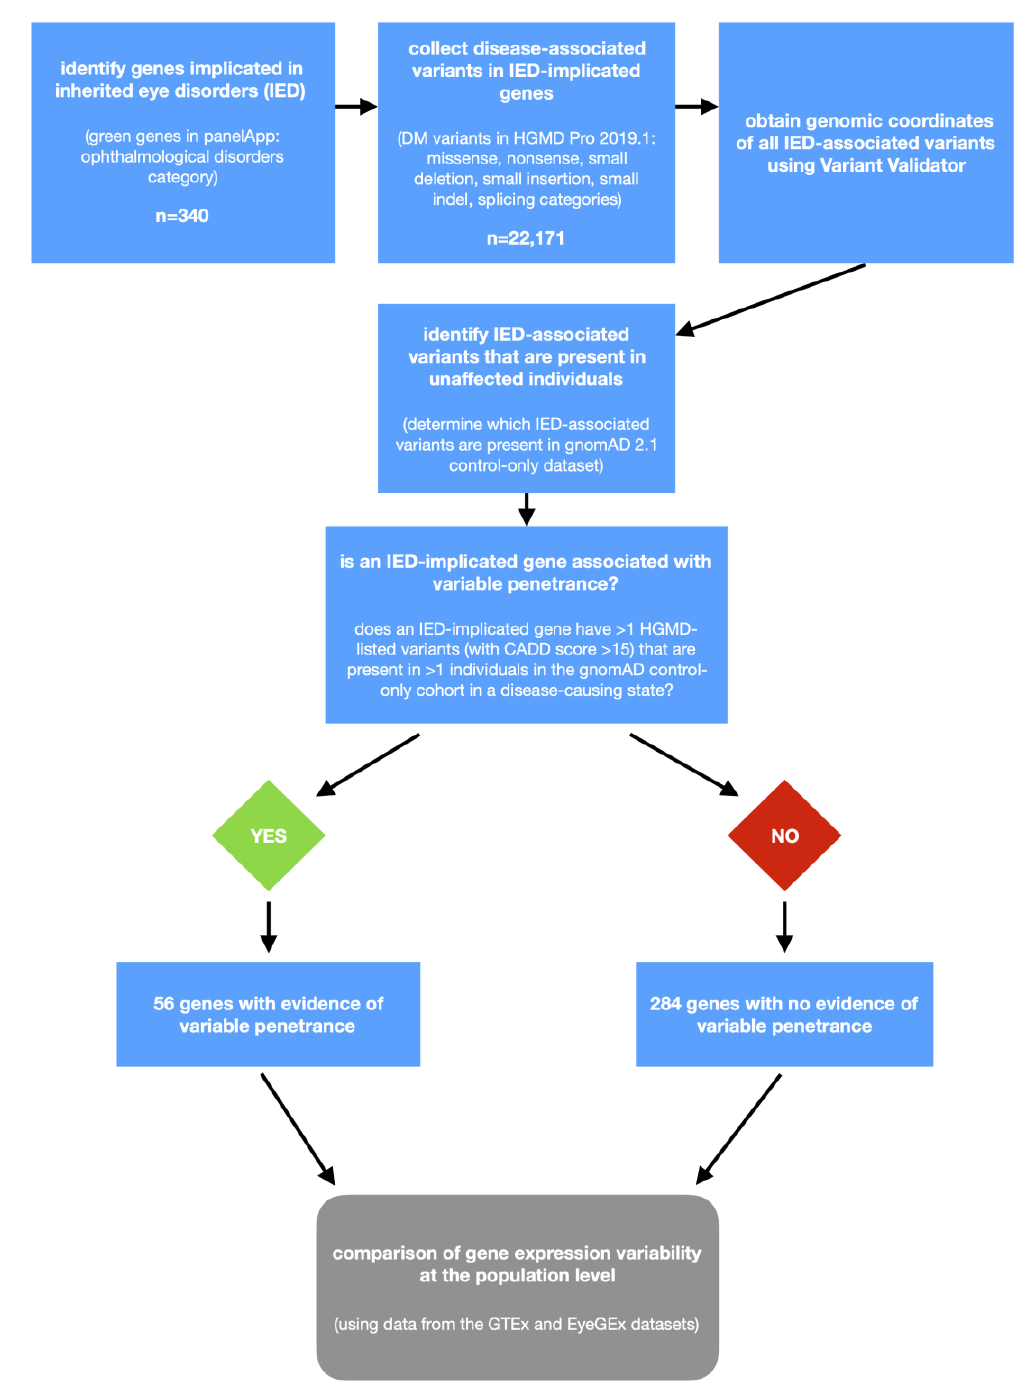
Figure 1. Flowchart outlining the study design of the project. IED, inherited eye disorders; HGMD, Human Gene Mutation Database; gnomAD, Genome Aggregation Database; CADD, combined annotation-dependent depletion; GTEx, Genotype-Tissue Expression project; EyeGEx, Eye Genotype Expression; and DM, disease mutation.